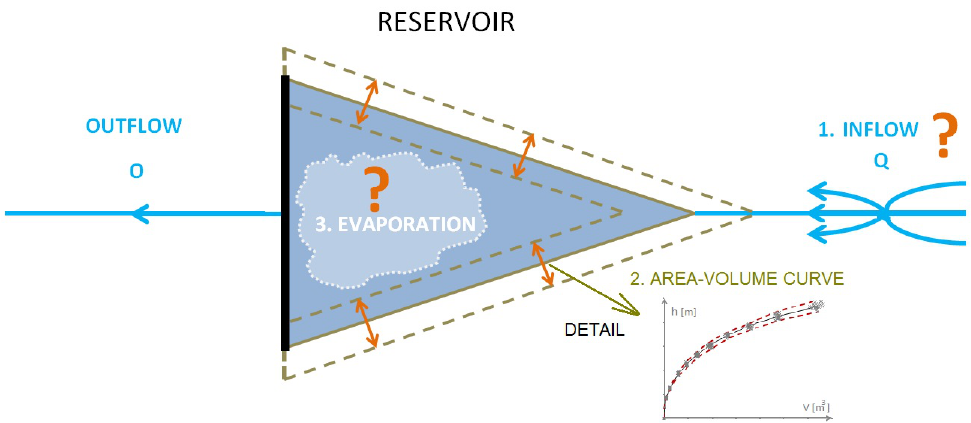
Figure 2. Symbolic introduction of reservoir parameters affected by uncertainties.